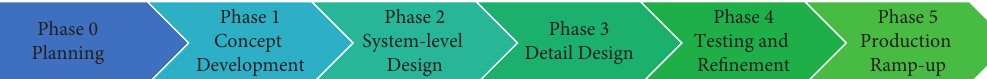
Figure 1: Product development process